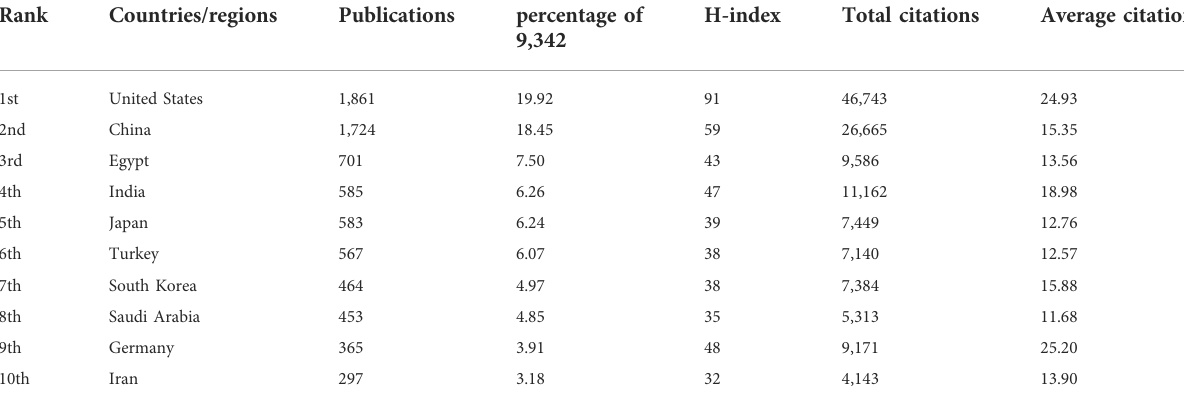
TABLE 1 Top 10 countries by publications, H-index, and citations in nephrotoxicity research. Rank